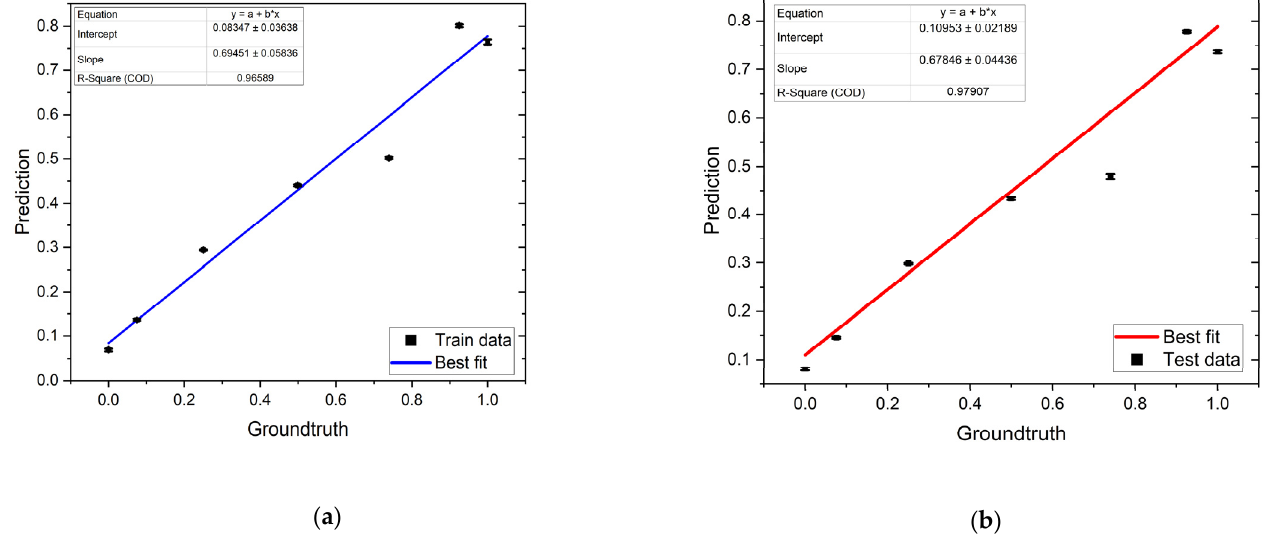
Figure 8. Representative hybrid model on ( a ) train and ( b ) test data.